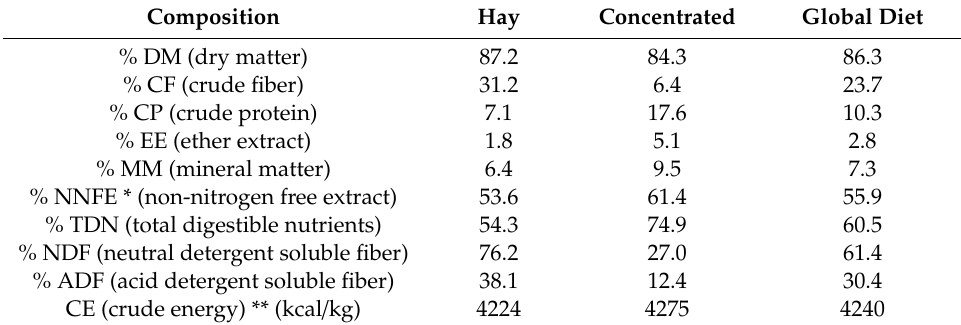
Table 1. Bromatological compositions of coast-cross hay, commercial concentrate, and global diet o ff ered to cattle during the experimental